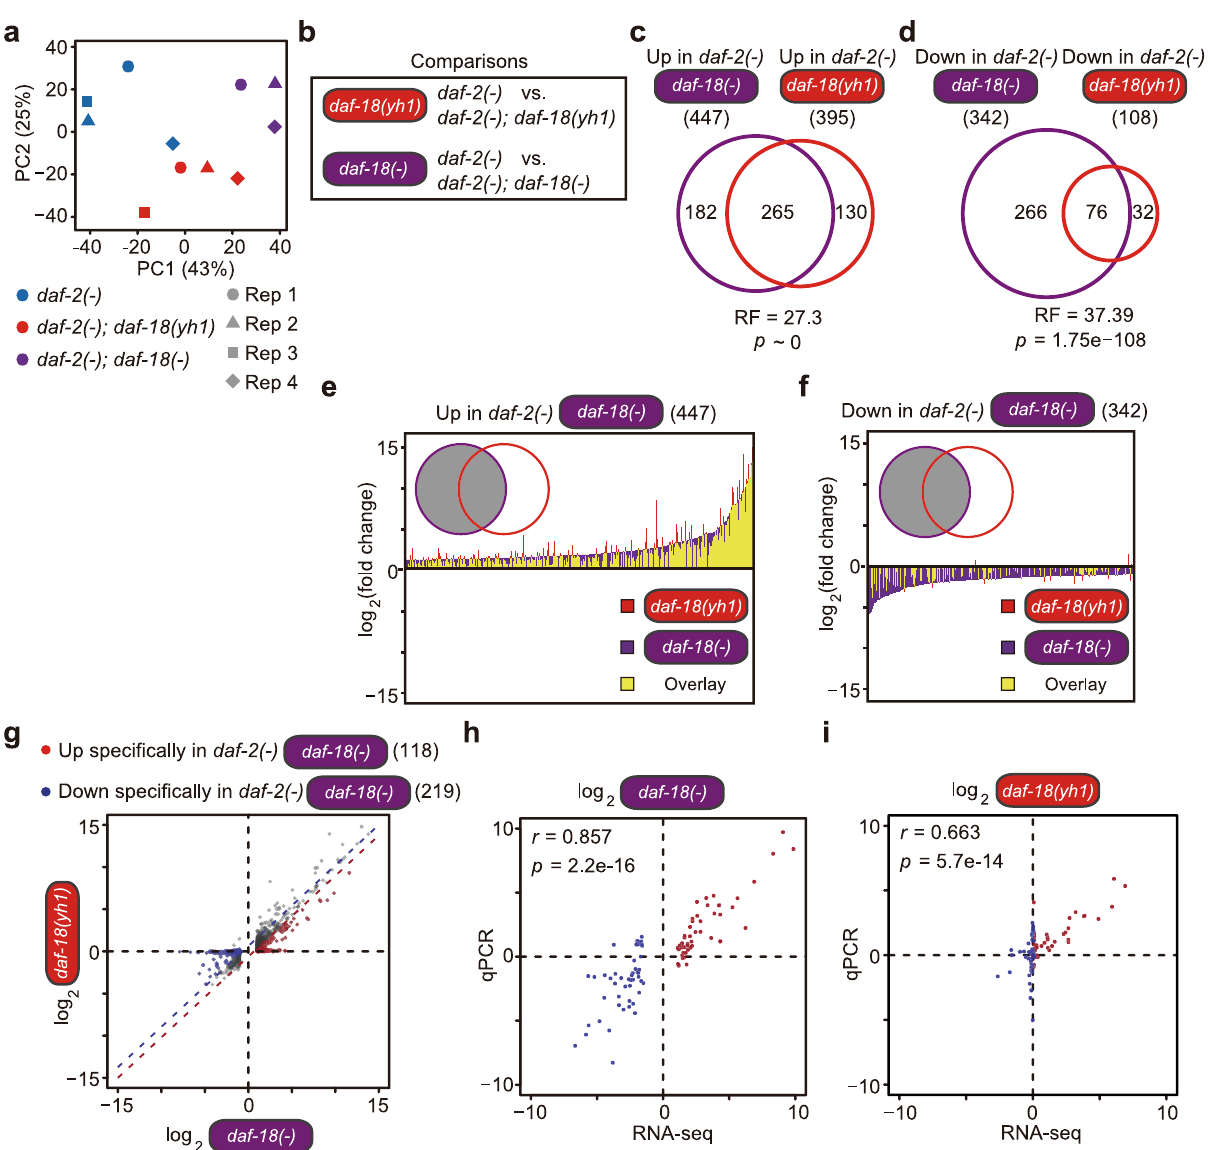
Fig. 4 daf-18(yh1) is a hypomorphic allele that differentially affects gene expression in daf-2( − ) mutants. a A principal component (PC) analysis showing relative distance among samples. b Two comparisons for subsequent analyses of RNA-seq data [red: daf-2( − ) vs. daf-2( − ); daf-18(yh1) , purple: daf-2( − ) vs. daf-2( − ); daf-18( − )]. c , d Overlaps between genes upregulated ( c ) and downregulated ( d ) in daf-2( − ) mutants compared to daf-2( − ); daf- 18( − ) or daf-2( − ); daf-18(yh1) mutants ( p values were calculated by using exact hypergeometric probability test. RF: representation factor). e , f Comparisons of the extent of gene expression changes between the two comparisons. Genes whose expression was upregulated ( e ) and downregulated ( f ) in daf-2( − ) mutants compared to daf-2( − ); daf-18( − ) mutants were considered. Overlaps between purple and red bars were marked in yellow. g A scatter plot showing the effects of daf-18( − ) and daf-18(yh1) mutations on gene expression in daf-2( − ) mutants. Shown are genes whose expression levels were speci fi cally upregulated (red dot: 118 genes) or downregulated (blue dot: 219 genes) in daf-2( − ) animals compared with daf-2( − ); daf-18( − ) worms (fold change > 2, Benjamini and Hochberg (BH)-adjusted p value < 0.05), but were only slightly altered compared with daf-2( − ); daf-18(yh1) animals (fold change < 2 relative to daf-18( − ) ) in daf-2( − ) mutants. See Supplementary Fig. 4 h, i, l, m for gene ontology and tissue enrichment analysis results of these genes. h , i Con fi rmation of the expression changes of the top 50-ranked genes in ( g ) by using quantitative RT-PCR. Both axes are log 2 -transformed. See Supplementary Fig. 5 and Supplementary Dataset 1 for